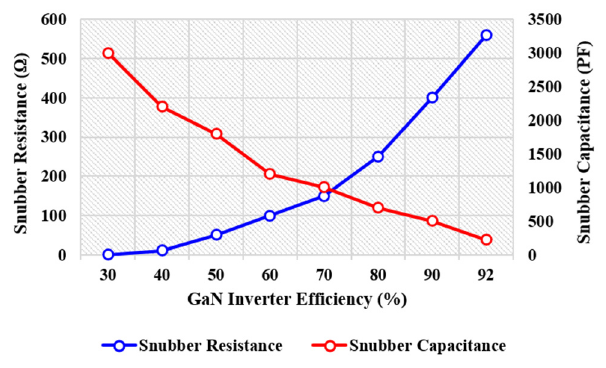
Figure 5. The snubber capacitance and resistance optimization based on the inverter efficiency.